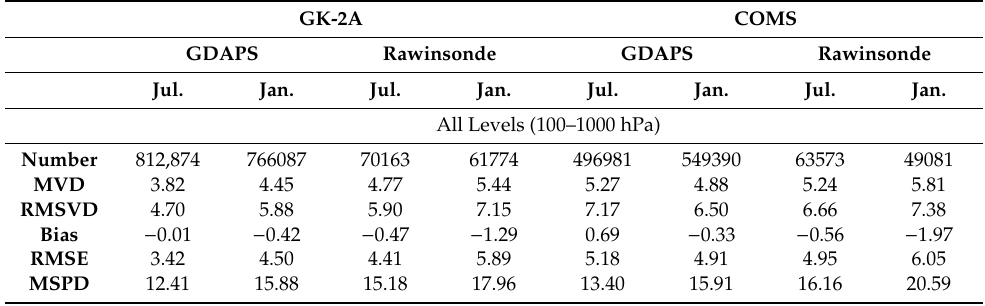
Table 3. Comparison of validation scores of GK-2A and COMS AMVs with GDAPS and rawinsonde over the ENH region for July 2016 and January 2017. The GK-2A AMVs generally had better performance than COMS AMVs, considering QIF > 80. GK-2A COMS GDAPS Rawinsonde GDAPS